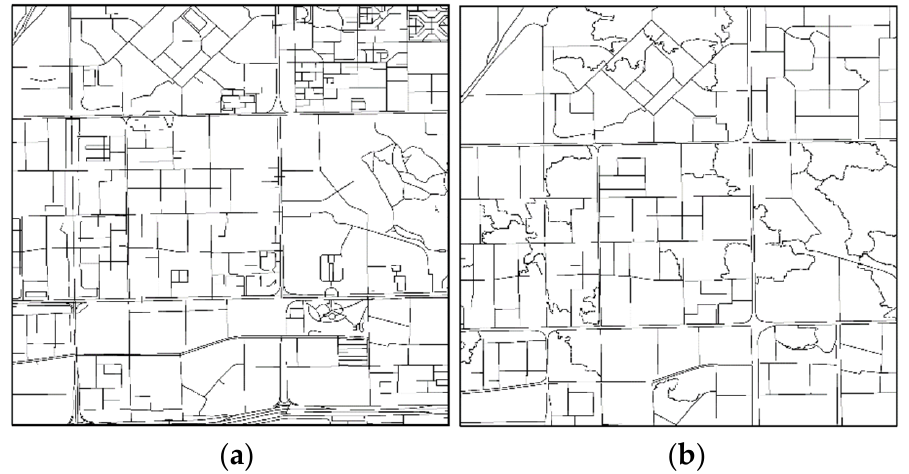
Figure 3. OpenStreetMap data preprocessing: ( a ) original OSM data, and ( b ) final road network after processing.